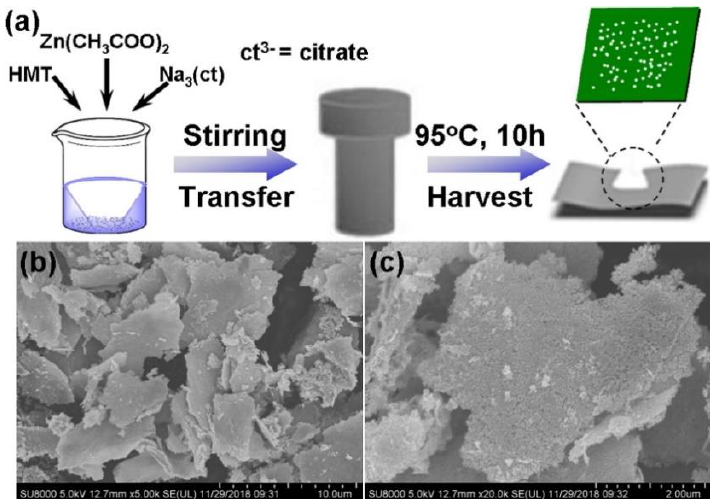
Figure 3. Schematic diagram for the synthesis ( a ); SEM images ( b , c )